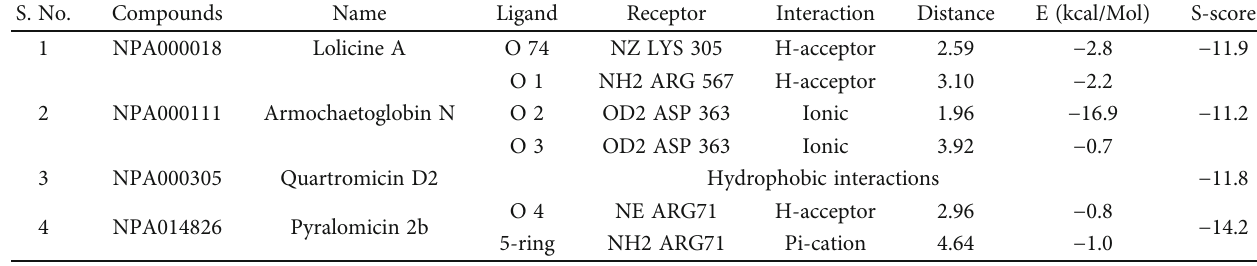
Table 4: The interaction detail of the shortlisted compounds.